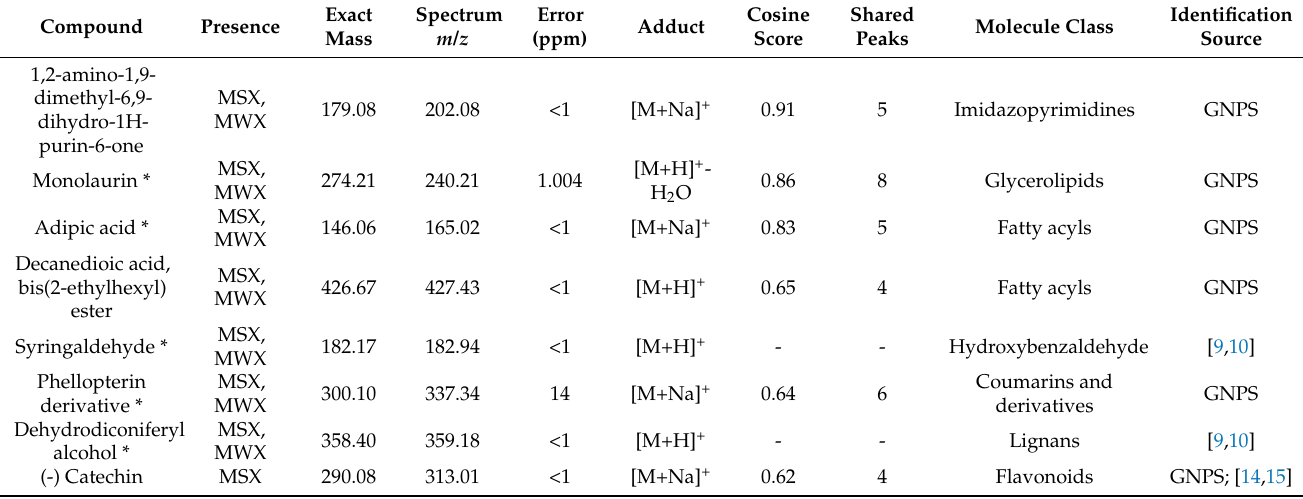
Table 2. Compounds present in maple food extracts, successfully dereplicated, through LC-MS/MS networking using the Global Natural Products Social Molecular Networking (GNPS) platform and previous research. Eight total compounds were able to be dereplicated. The cosine score and shared peaks columns represent the similarity in spectra from the maple food extract(s) and library ‘hit’ spectra from the GNPS platform. * in molecular